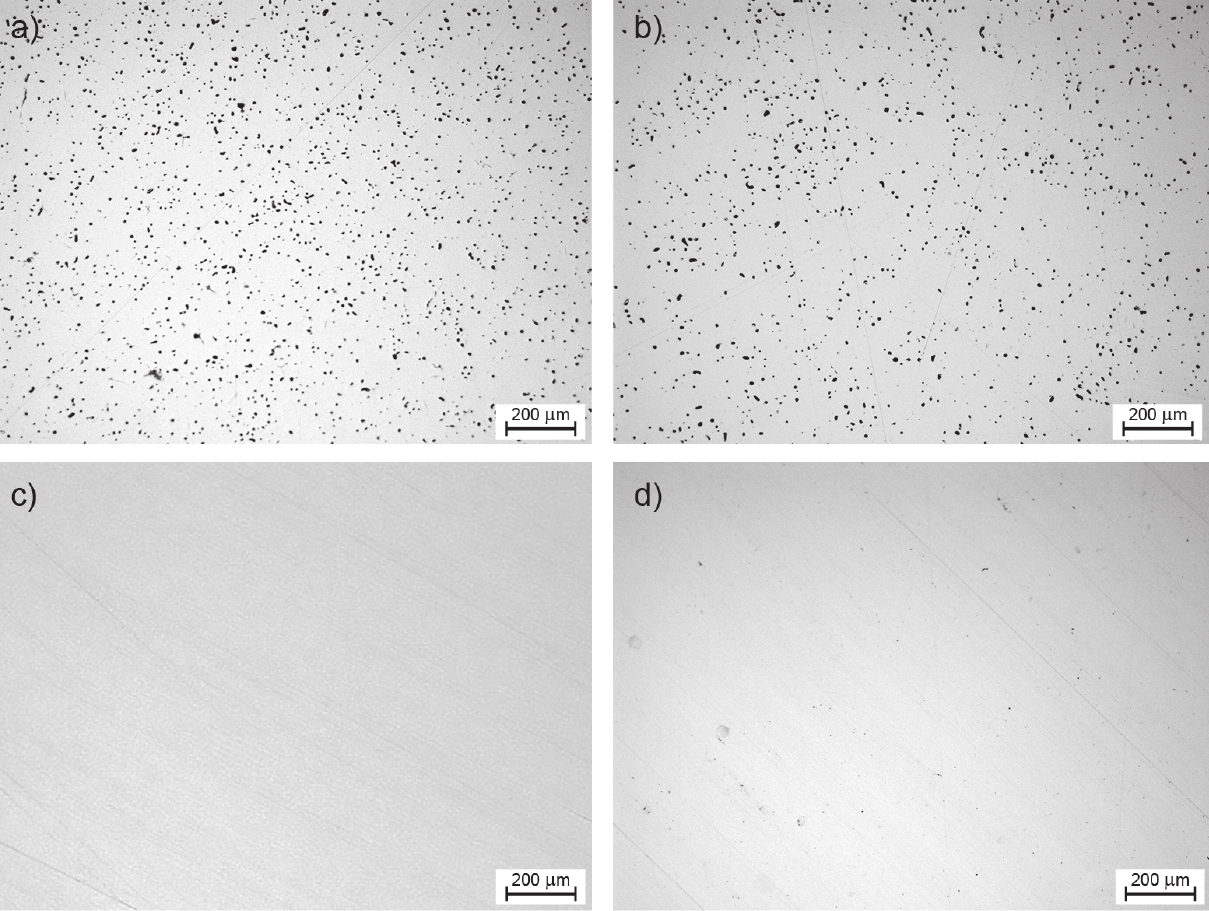
Figure 3. Optical micrographs of polished samples sintered in N 2 -5%H 2 at 1325 °C during ( a ) 4 h of plateau, ( b ) 12 h of plateau, ( c ) 4 h of plateau and hot isostatic pressing (HIP) treatment and ( d ) 12 h of plateau and HIP